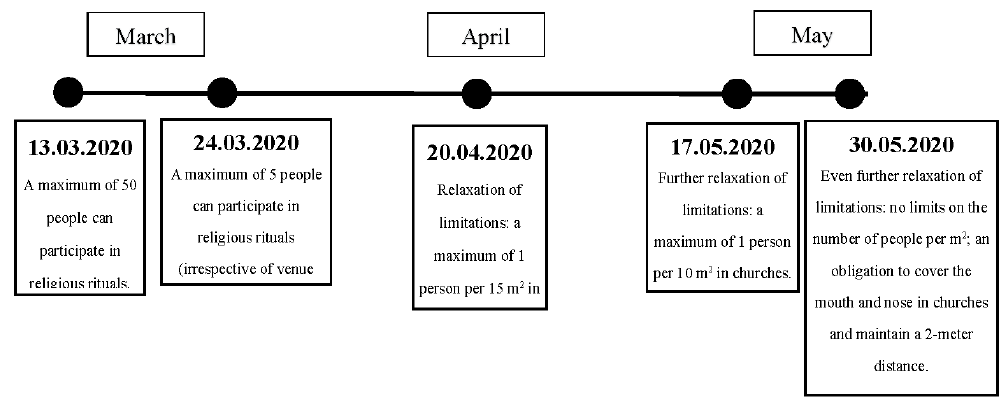
Figure 1. Timeline of the various restrictions introduced. Source: Based on Polish Ministry of Health (Ministerstwo Zdrowia 2020).